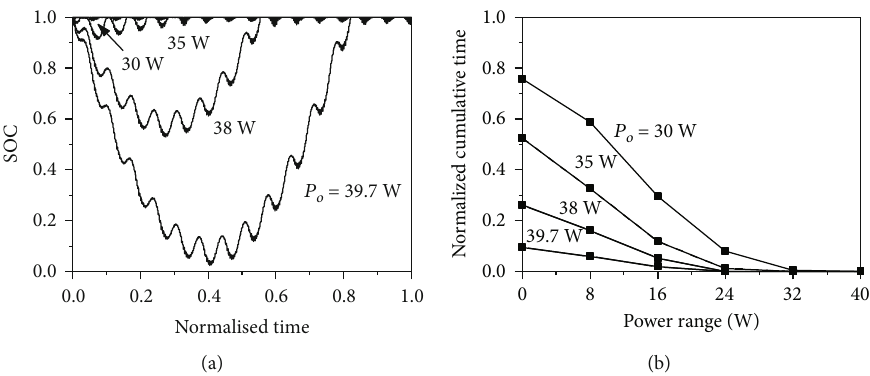
Figure 9: Working performance at di ff erent power consumptions: (a) SOC v. time; (b) waste power v. cumulative time; the abscissa plots the power range from x to 40